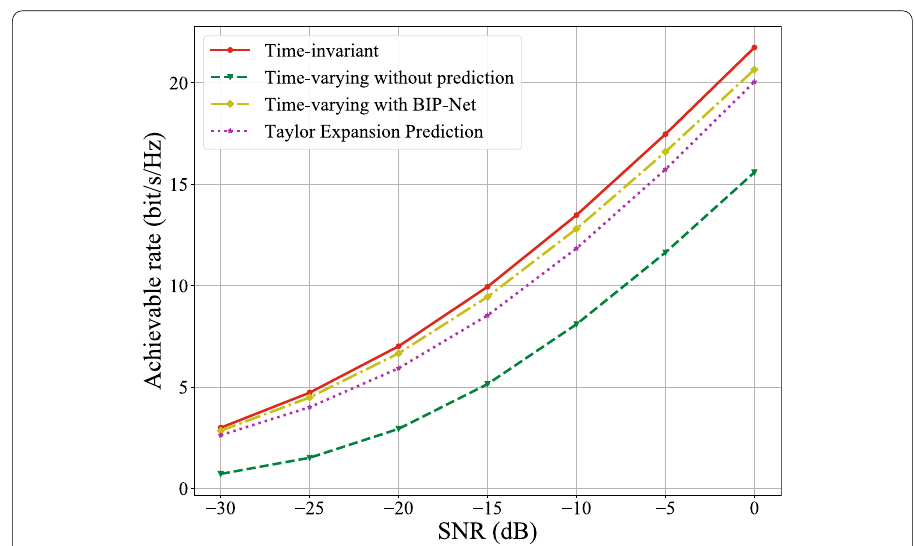
Fig. 13 Achievable rate comparison among time-invariant situation, time-varying situation without BIP-Net and time-varying situation with BIP-Net. Legend: Time-invariant. Time-varying without prediction. Time-varying with BIP-Net. Taylor expansion